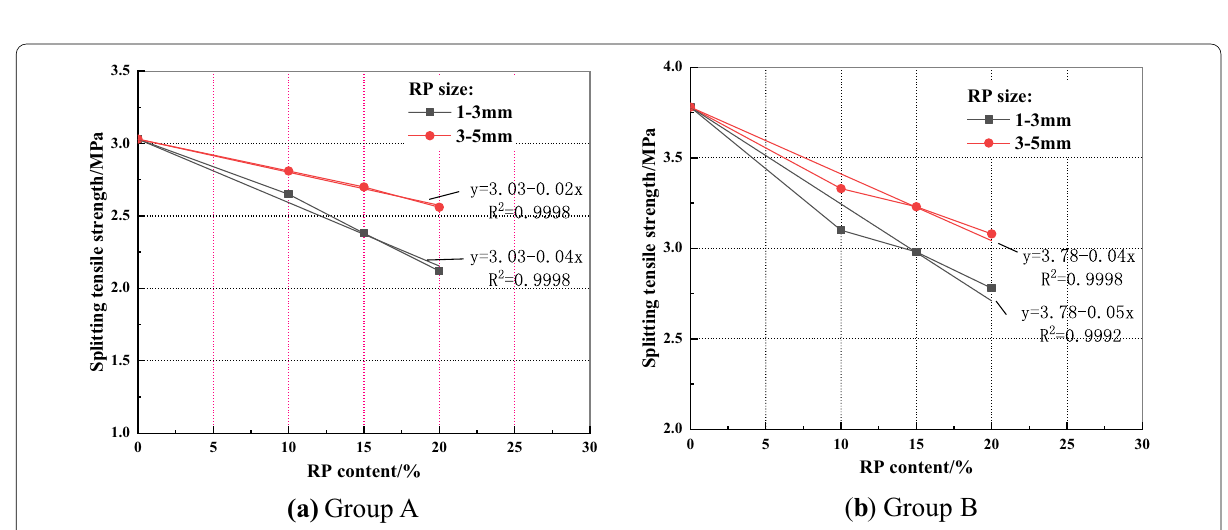
Fig. 11 Relationship between the compressive strength of concrete and RP